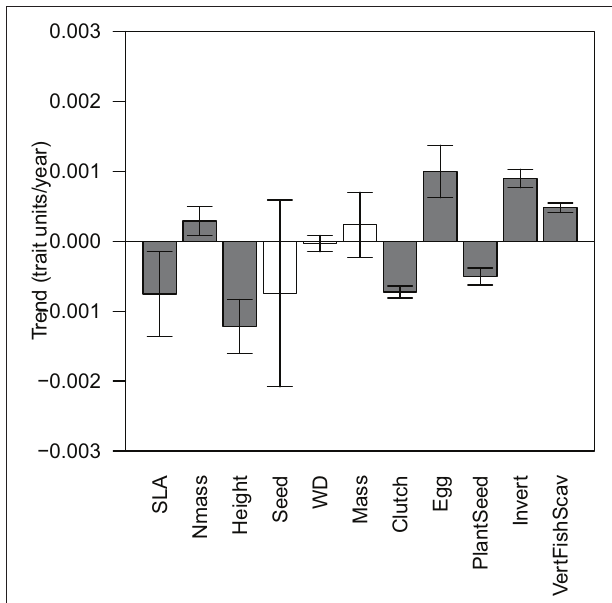
FIGURE 3 | The mean magnitude of trends through time in each functional trait. Error bars show in the 95% confidence interval, and bars whose intervals overlap 0 are shown in